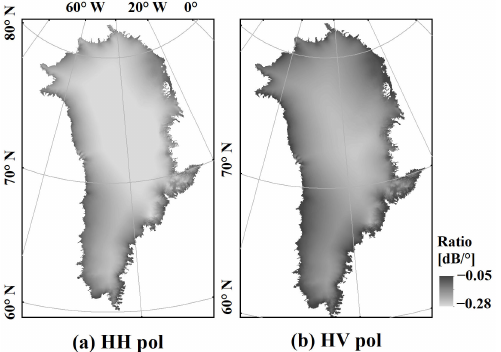
Figure 2. The ratio of HH and HV polarization over the whole GrIS, calculated by Equation (1) with the regression coefficients shown in Table